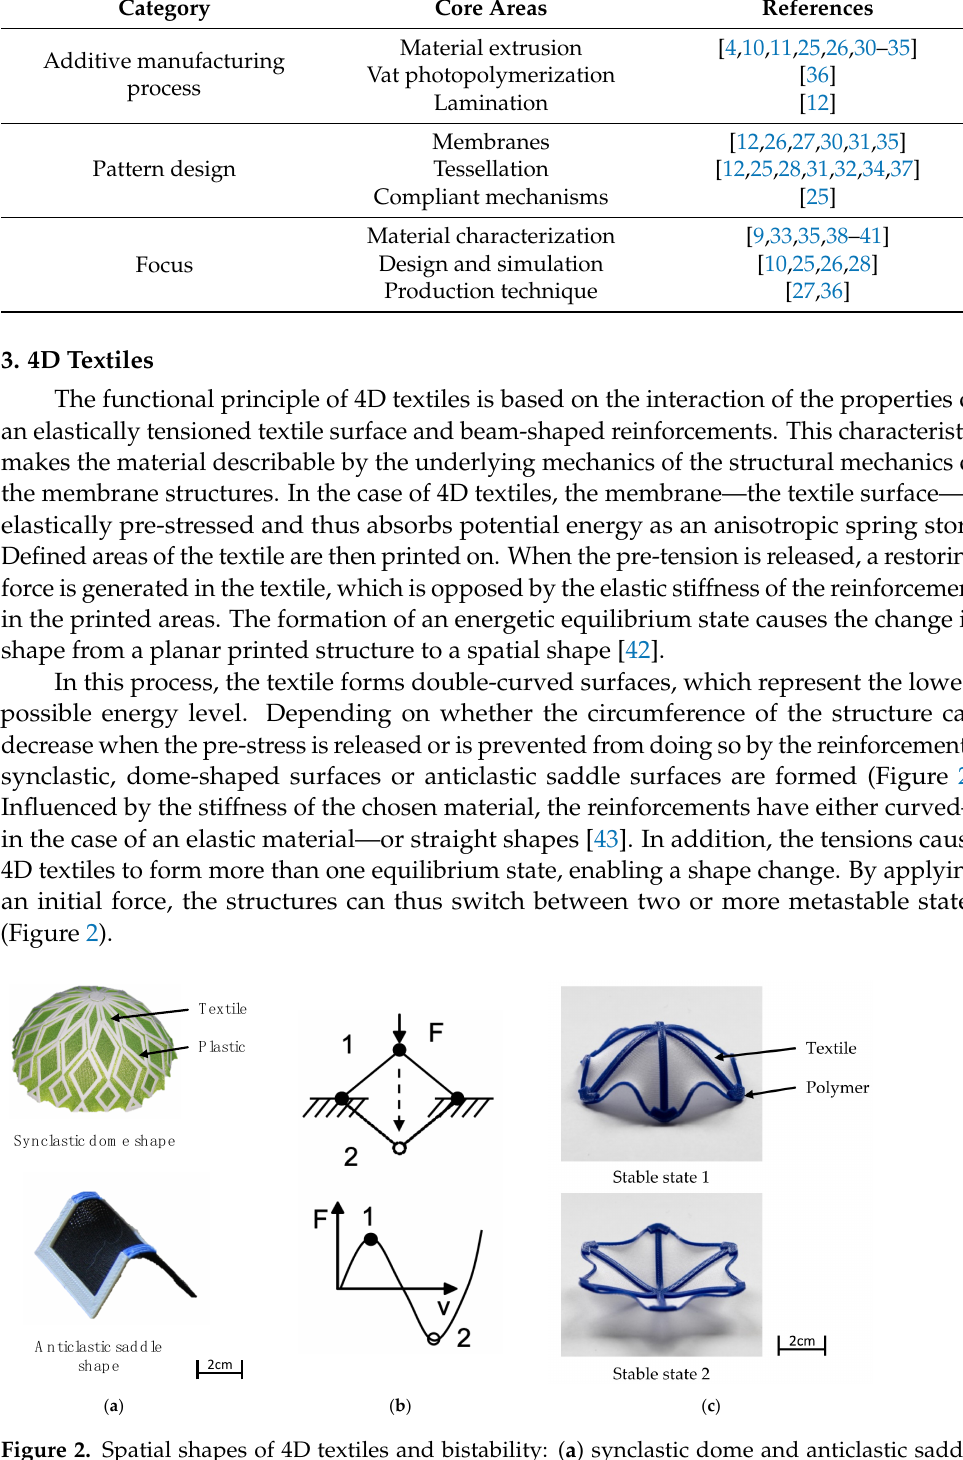
Table 1. Categorization of research on 4D textiles made by additive manufacturing on textiles.